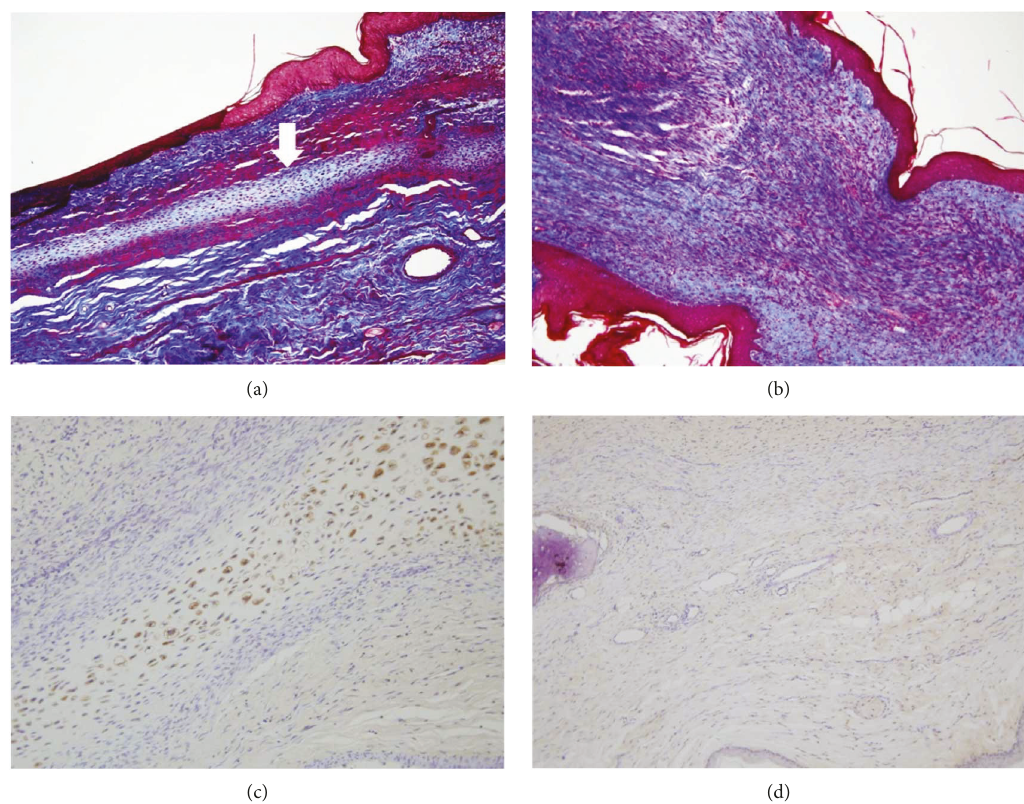
Figure 5: Masson ’ s trichrome stain and immunohistochemistry. Masson ’ s trichrome staining showed pale blue-colored cartilage formation (arrow) in the experimental group (a) and only collagenous tissue in subepithelial region of the control group (b). Imunohistochemistry for S-100 showed strongly stained chondrocytes and chondroblasts in the experimental group (c), but not in the control group (d) (magni fi cation, 200x).